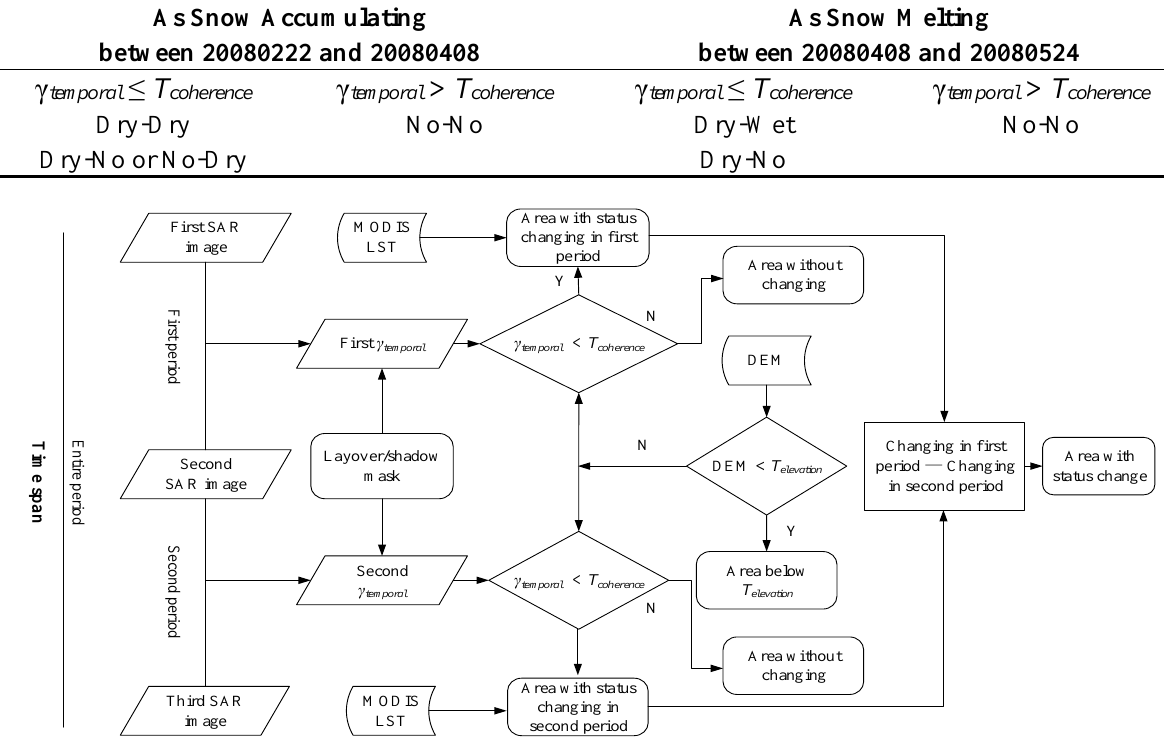
Figure 3. The algorithm to map area with or without snow change using γ temporal for locations above tree line in the first, second, and entire